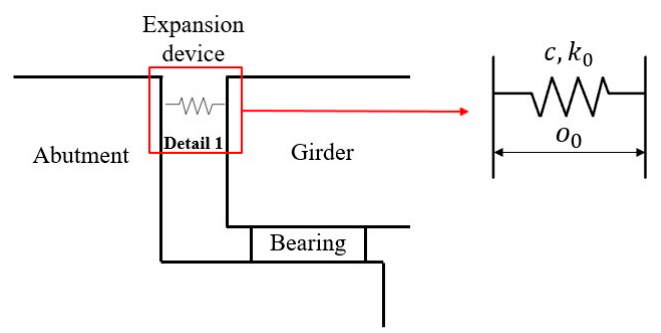
Figure 2. Finite element model of expansion devices.